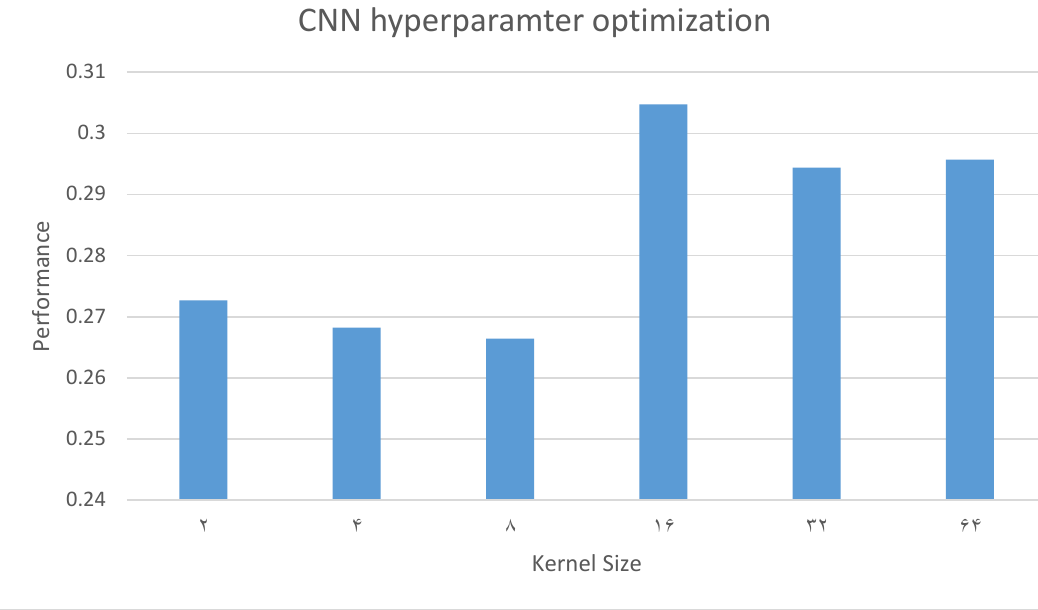
Figure A-5 Optimized Kernel size of Convolution layer of CNN models